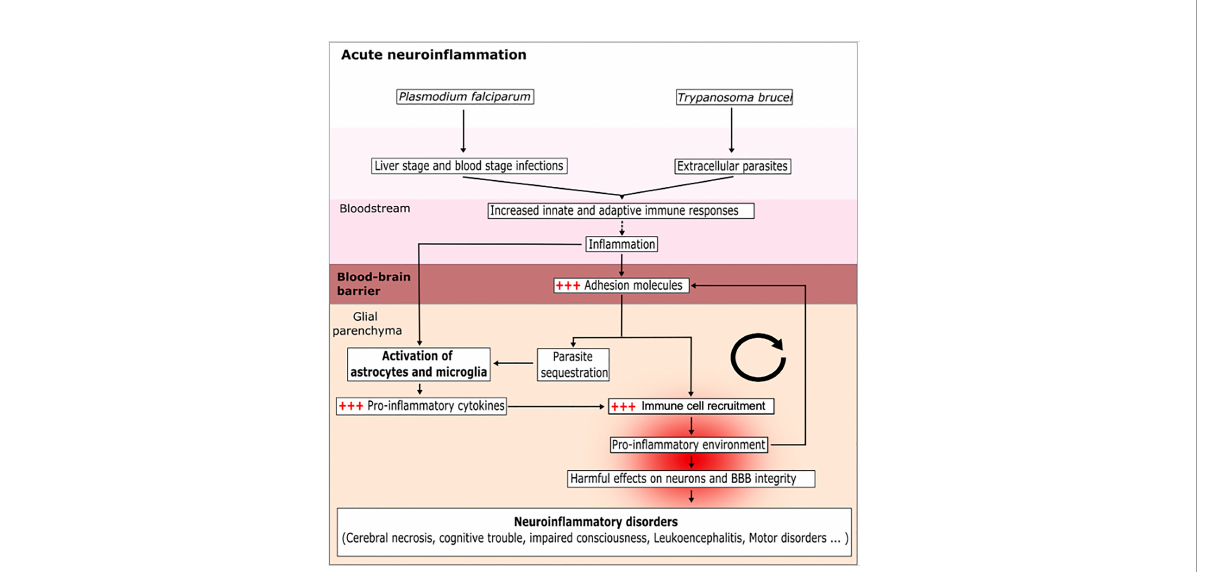
FIGURE 1 Mechanisms of the acute CNS in fl ammation induced by a protozoan parasite infection. The parasites P. falciparum and T. brucei enter the blood and then infect various cell types, in order to escape the immune system and splenic clearance. During this phase, the parasites activate circulating immune cells; in turn, this induces in fl ammation and favors the expression of adhesion molecules (ICAM-1 and VCAM-1) by endothelial cells and the activation of glial cells (astrocytes and microglia). This results in a vicious circle because the in fl ammation makes it easier for parasites to enter and accumulate in the glial parenchyma. The sensing of parasites by the glial cells induces the production of pro- in fl ammatory cytokines, allows the recruitment of immune cells and creates a pro-in fl ammatory environment. The brain in fl ammation disturbs the BBB and helps the parasite to invade the glial parenchyma. The accumulation of parasites exacerbates the activation of astrocytes and microglia cells and leads to a harmful, pro-in fl ammatory